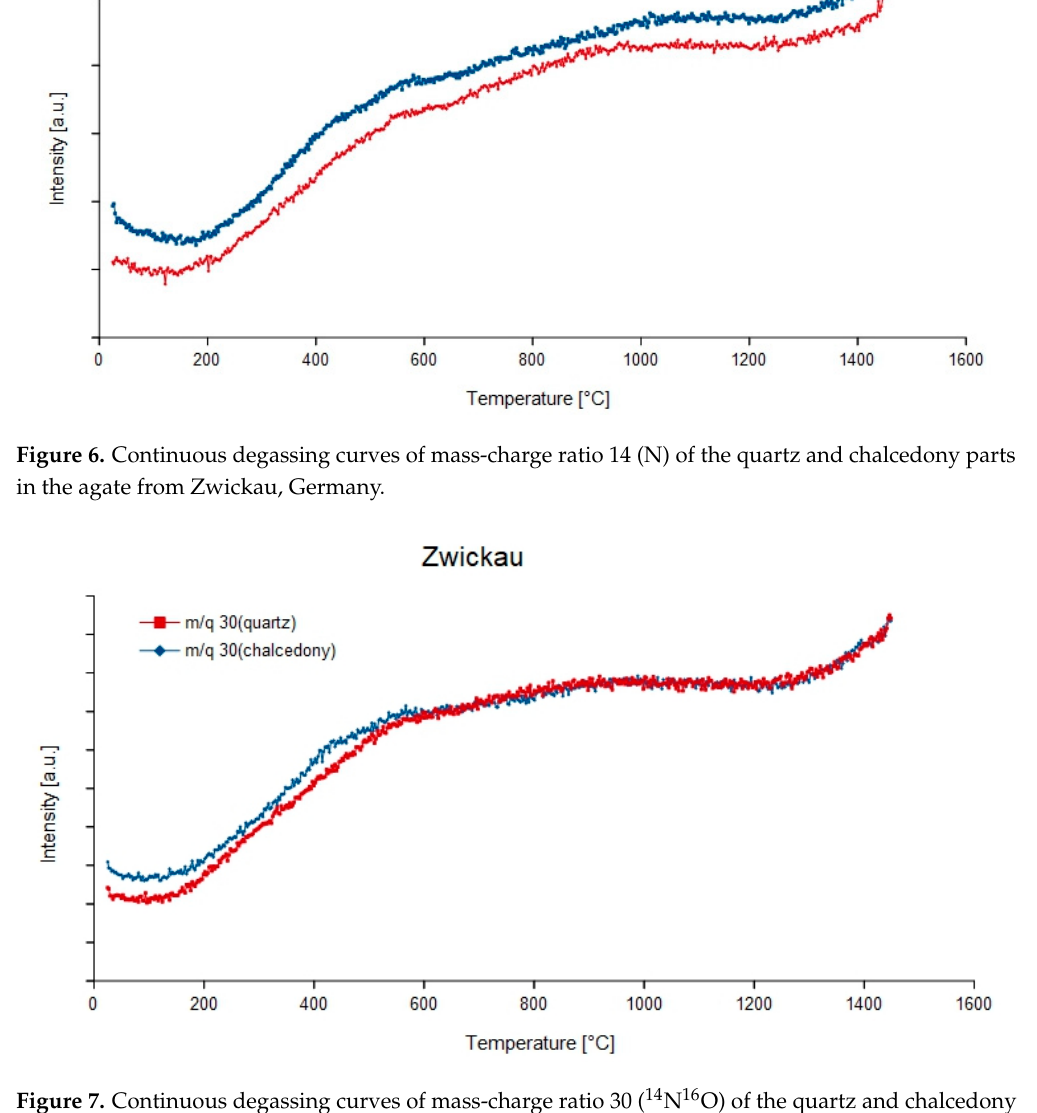
Figure 8. Degassing curves of the mass-charge ratio 46 ( 14 N 16 O 2 ) of quartz and chalcedony in the agate sample from Chemnitz- Furth, Germany. 3.1.4. Fluorine Fluorine compounds are associated with the mass-charge-ratios 19 to 21 (F = 19, HF = 20 and 21). The fluorine molecule 19 F 2 appears at the mass-charge ratio 38. The degassing temperature was found mainly around 500 °C but also rises up to 1000 °C. Results of [20] with degassing temperatures around 900 °C confirm the recent measurements. Due to their overlap with water (m/z =18 – 20) the curves for 19 F and 1 H 19 F do not show one clear peak but either several peaks (e.g. Rio Grande do Sul, St. Egidien in Figure 9) or a continuous curve of degassing. The interference of water with 19 F and 1 H 19 F might be low but cannot be ignored. 19 F 2 interferes with 1 H 37 Cl and 12 C 31 H 2 .